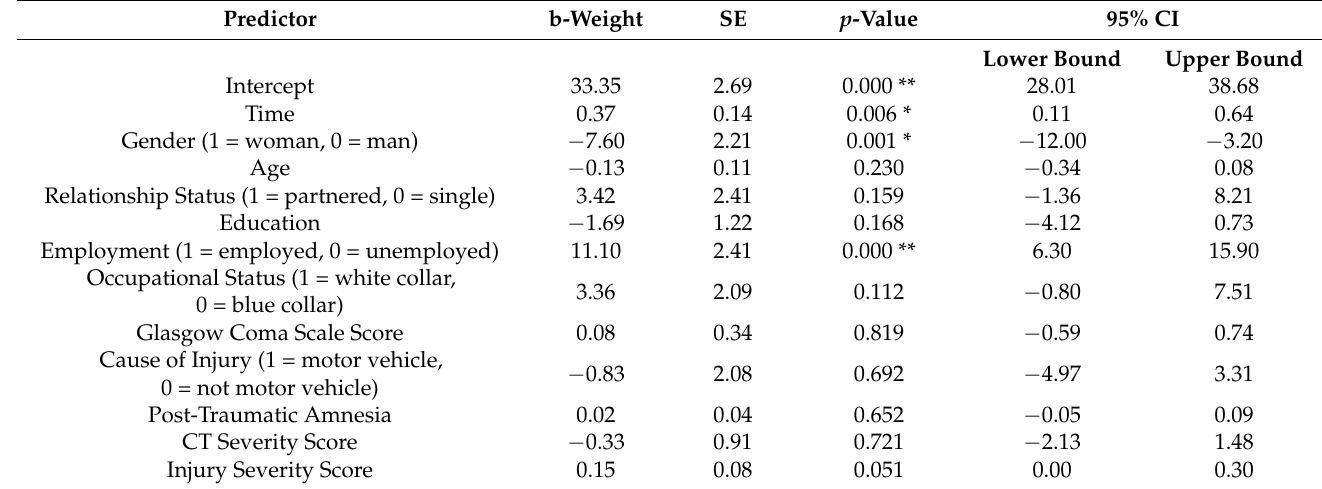
Table 4. Socio-demographic and injury predictors of the mental health (MCS) trajectories across 1, 2, 5, and 10 years.